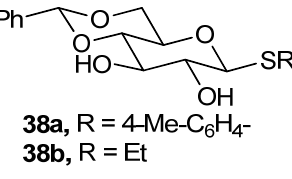
Figure 27. Thioglucoside based organogelators.